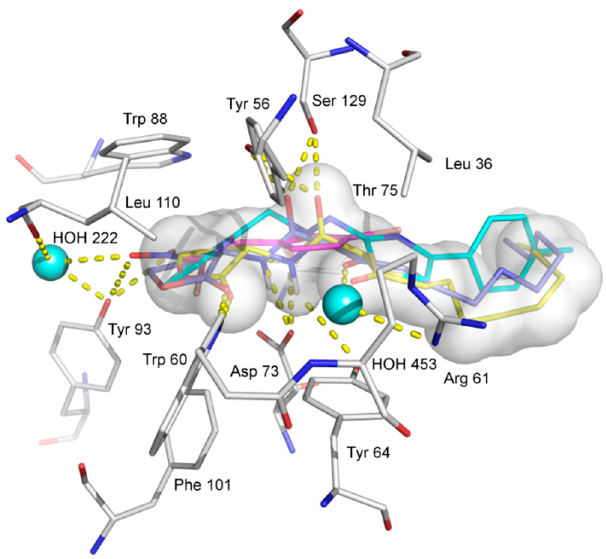
Figure 7. Docked ligands HL in cyan, docked known inhibitor furvina in magenta, docked known binder 3-oxo-C12-HSL in slate (HET-ID OHN), co-crystallized (X-ray) known binder 3-oxo-C12-HSL in yellow, in the binding site of transcriptional activator protein LasR (3IX3) in white, hydrogen bonds as dashes, sulphur in yellow, oxygen in red, nitrogen in blue, and halogen in salmon.